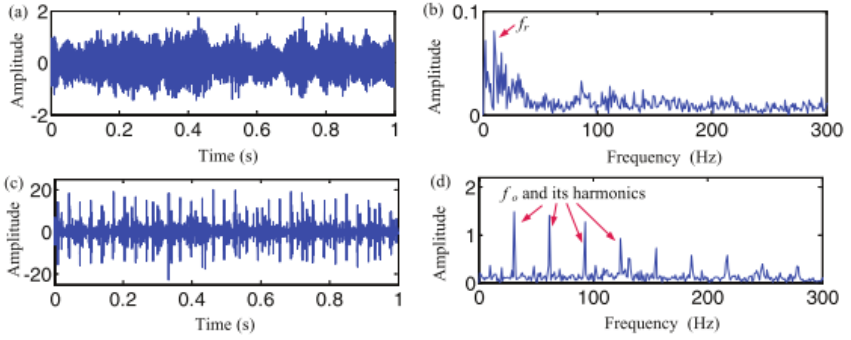
Figure 13. RSSD results and the instantaneous amplitude spectra of resonance components: ( a , c ) Optimal high and low-resonance components, respectively; ( b , d ) Instantaneous amplitude spectra of ( a , c ), respectively [52].